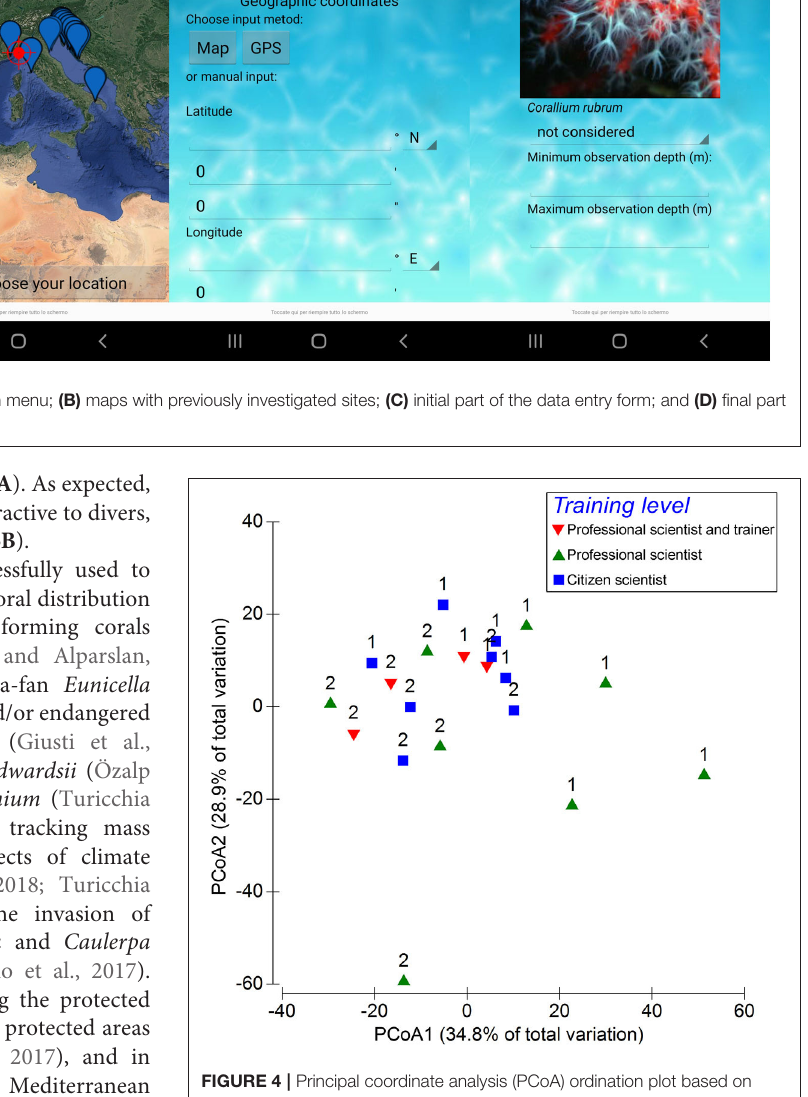
FIGURE 4 | Principal coordinate analysis (PCoA) ordination plot based on Bray–Curtis similarities comparing species assemblages detected by scuba divers with different training levels along the same pathway at two sites (Sites 1 and 2 are indicated by numbers) at Gallinara Island (Ligurian Sea). The training level is indicated with symbols and